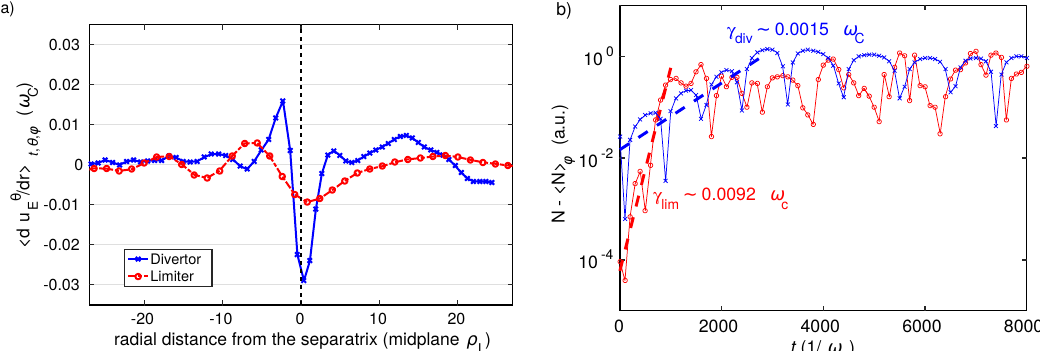
Figure 8. ( a ) Radial shear of the E × B poloidal velocity averaged in time and over the flux surface and remapped at LFS midplane in a COMPASS-like and in a limiter simulation. ( b ) Time trace of density fluctuations, calculated at the LFS midplane at R mp − R mp sep (cid:39) − 24 ρ L , including the linear phase, in divertor and limiter configurations. Dashed lines indicate the exponential fit used to evaluate the linear growth